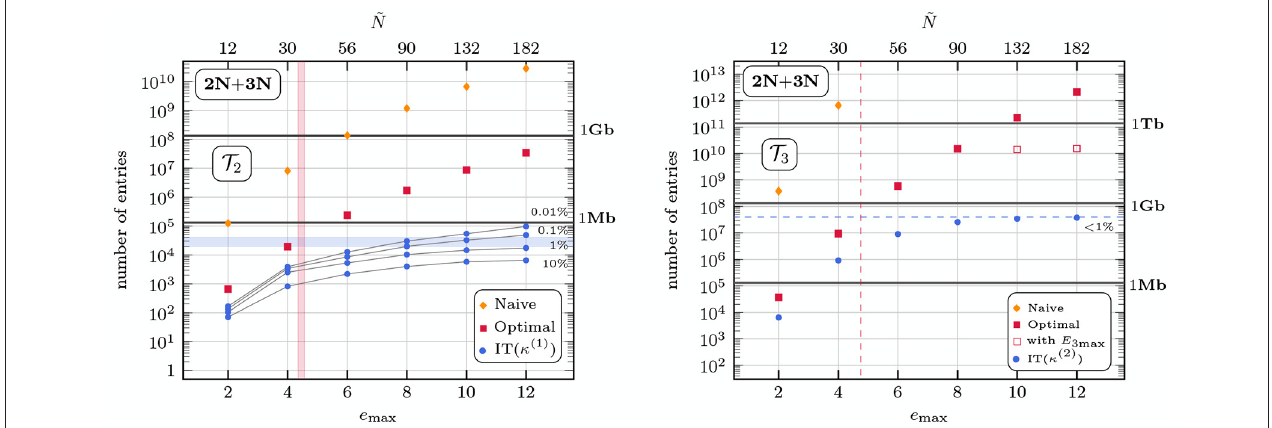
FIGURE 11 | Number of tensor entries of T 2 amplitudes (left) and T 3 amplitudes (right) as a function of model space using the Hamiltonian described in section 3. The oscillator frequency is given by ¯ h ω = 20MeV. Different plot markers indicate different storage scheme including all entries ( (cid:4) ), symmetry-allowed entries ( (cid:4) ), and IT-compressed entries ( l ). For e max ≥ 10 an additional E 3max -truncation ( (cid:3) ) for the T 3 amplitudes is introduced. All calculations employ a canonical HFB reference state. Reproduced from Tichai et al. [ 107] with permission from European Physical Journal